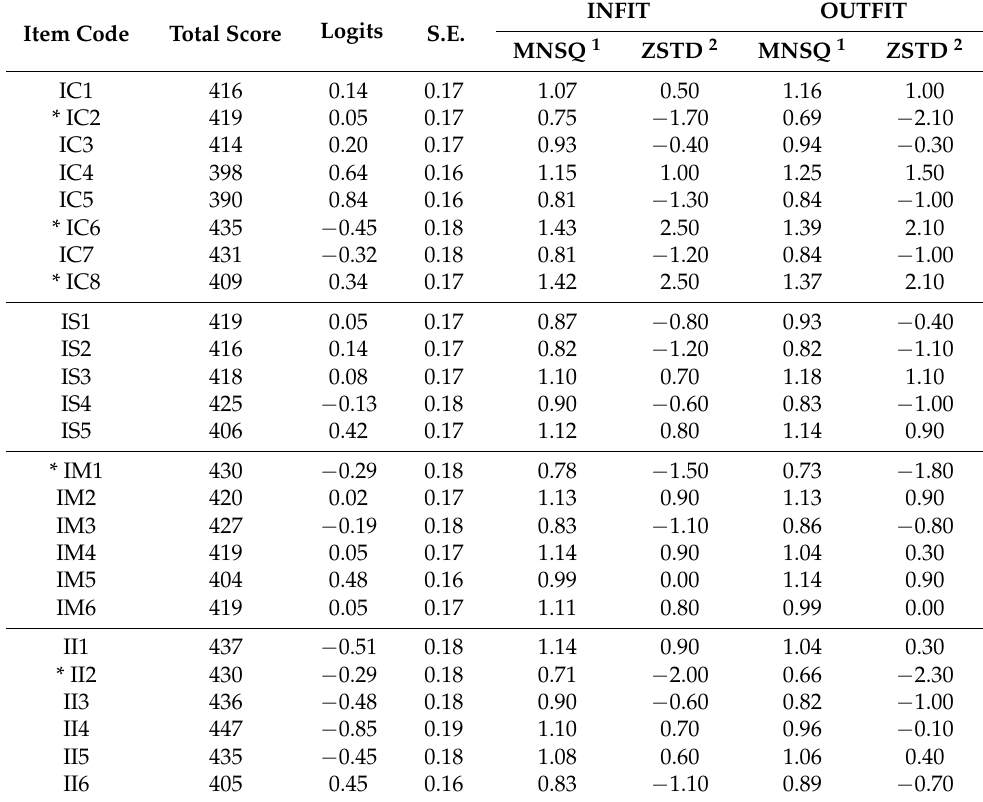
Table 4. Item fit for transformational leadership items.